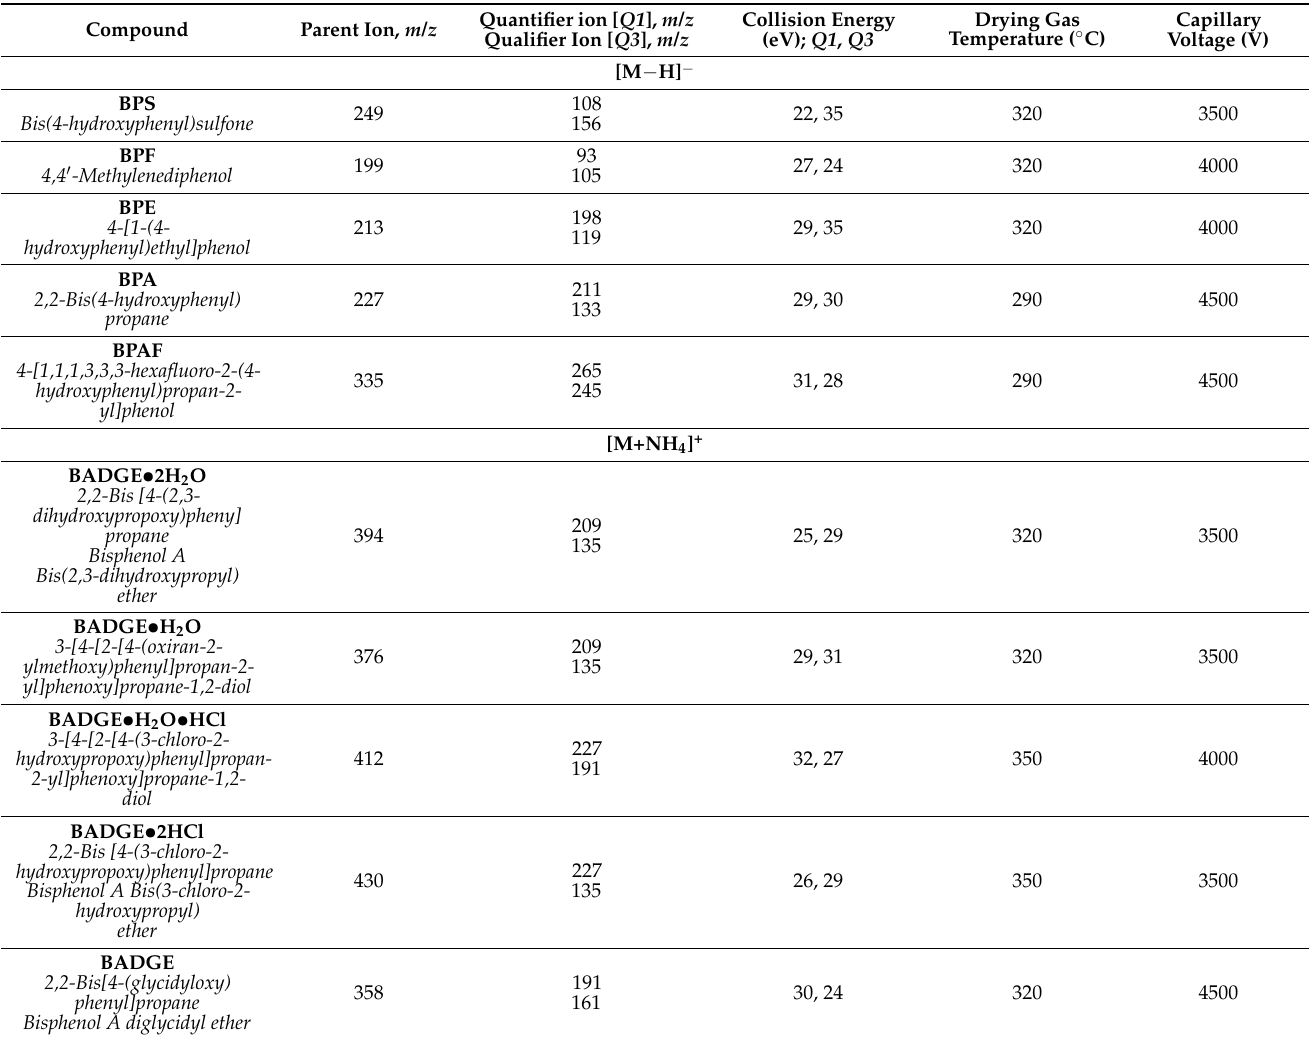
Table 1. MS/MS conditions used for determination and identification of selected bisphenols in amniotic fluid